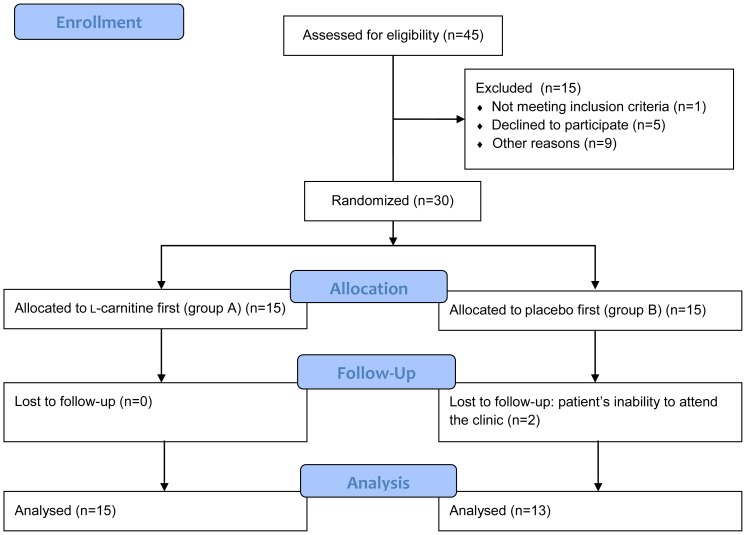
Study flow diagram.